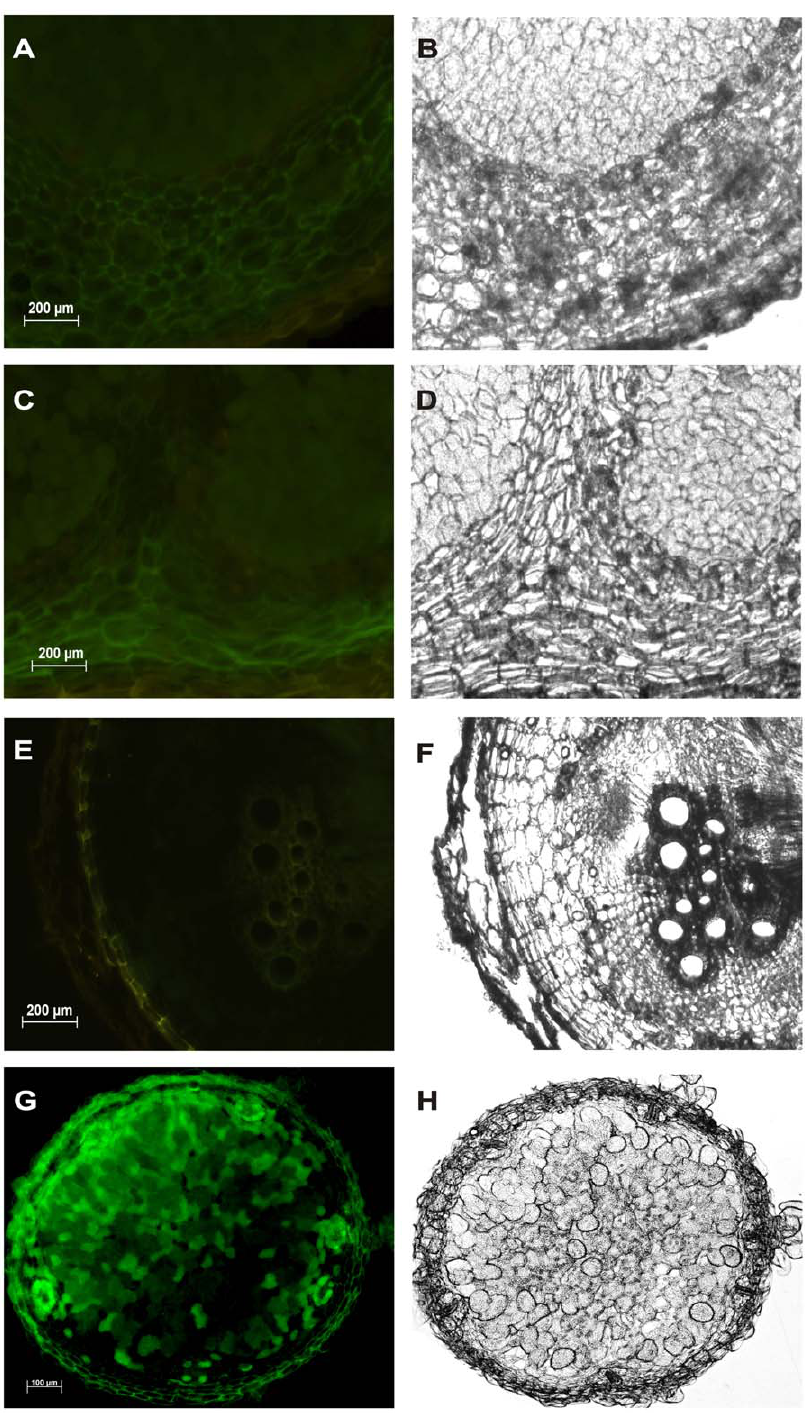
Figure 1. NO detection in A.hypogaea JL 24 and M.sativa nodules. All nodule sections were incubated with 10 m M DAF-2DA at 25 u C for 1 hour in darkness. Photographs are representative of results obtained from the analysis of nodules in five independent experiments. Images of A. hypogaea nodule sections show absence of NO dependent DAF-2DA fluorescence (green colour) in (A) 20 day, (C) 40 day and (E) 80 day old nodules. (B), (D) and (F) show the corresponding bright field images. Scale bar=200 m m. Whereas DAF-2DA dependent green colour fluorescence was observed in (G) 143 day old M. sativa nodule section. (H) represents the corresponding bright field image. Scale bar=100 m m. The images of the sections were captured using excitation at 485 nm and emission at 530 nm. doi:10.1371/journal.pone.0045526.g001 probe. In other samples the level of endogenously biotinylated indicating the level of endogenously biotinylated proteins were proteins could not be detected under our experimental conditions low. We also checked for protein tyrosine nitration in nodule